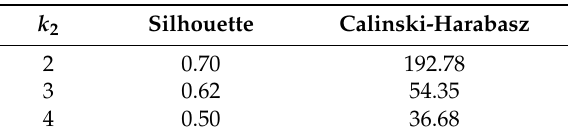
Table 2. Silhouette and Calinski-Harabasz measures for different k 2 (i.e., the number of clusters at the second step of the proposed approach), where k 1 = 3 has been selected.